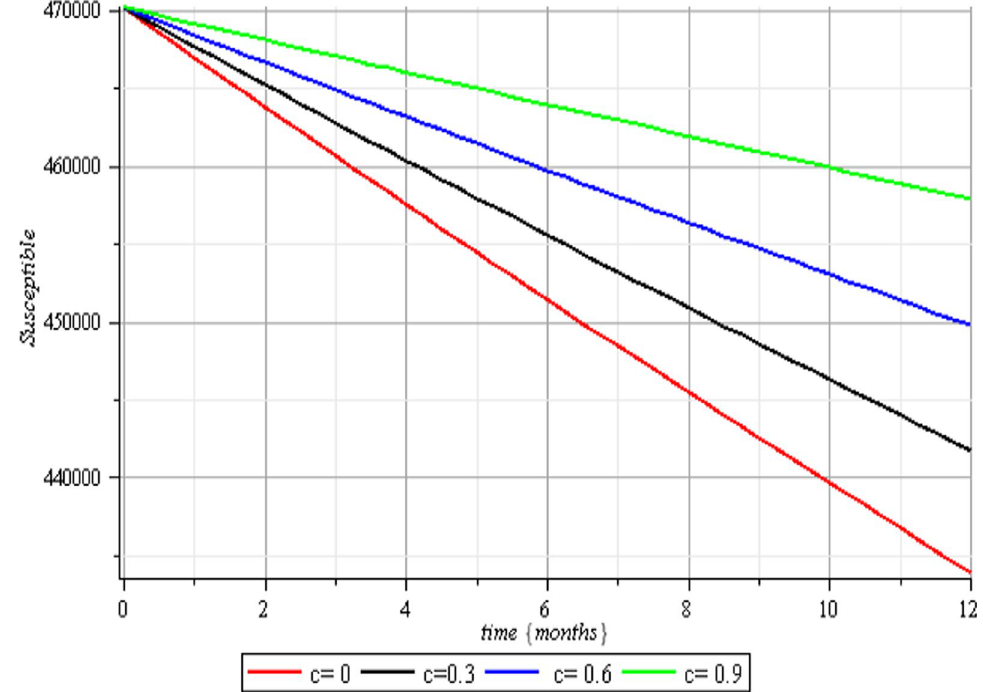
Fig. 2 Effects of human submission to physical limitation on the susceptible class